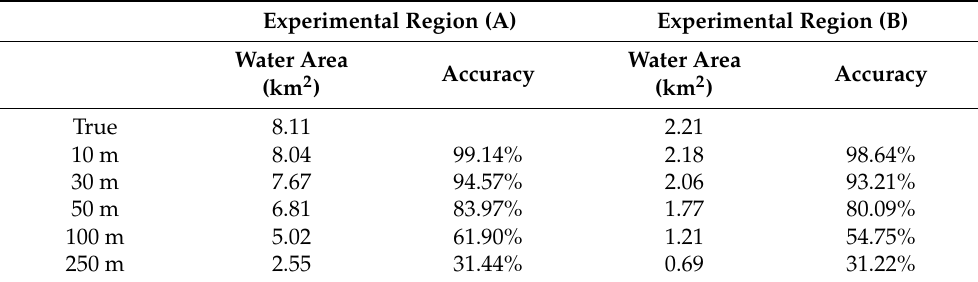
Figure 5. Optimization effect on urban water body extraction: ( a ) Sentinel ‐ 2A false ‐ color synthetic image of the study area in 2020, ( b ) AWEIsh with automatic threshold extraction, ( c ) AWEIsh ∩ USI extraction results, and ( d ) AUSWM extraction results. Table 3. Urban surface water areas and accuracies derived from multi-source and multi-resolution remote sensing